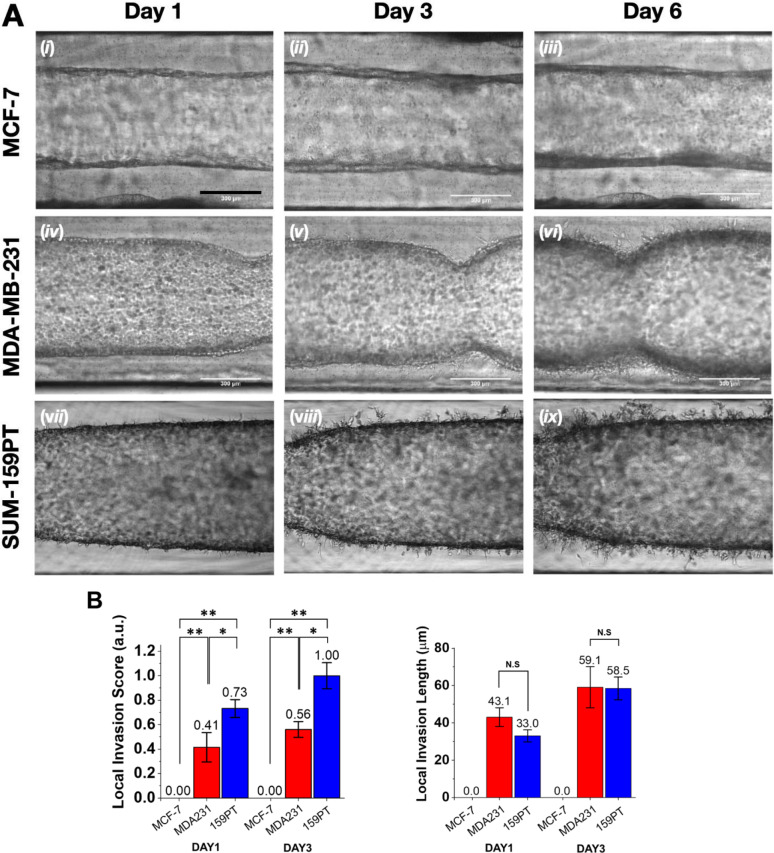
Invasion assay of three subtype-specific breast cancer cell lines in IDC-on-chip.(A) Time-lapse micrographs of MCF-7, MDA-MB-231 and SUM-159PT ducts in IDC-on-chip at day 1, 3 and 6. Scale bars indicate 300 μm. (B) Quantification of local invasion on DAY1 and DAY3. (C) Quantification of local invasion length. MCF-7; MDA231, MDA-MB-231; 159PT, SUM-159PT; Bar; mean ± standard error. N.S; p>0.05, *; p < 0.05, and **; p < 0.01 (Student t-test).